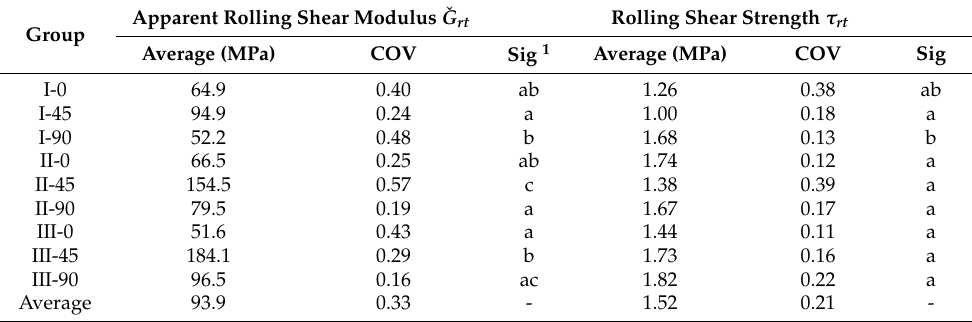
Table 1. The apparent rolling shear modulus and rolling shear strength of different configurations. Apparent Rolling Shear Modulus 𝑮(cid:3545) 𝒓𝒕 Group